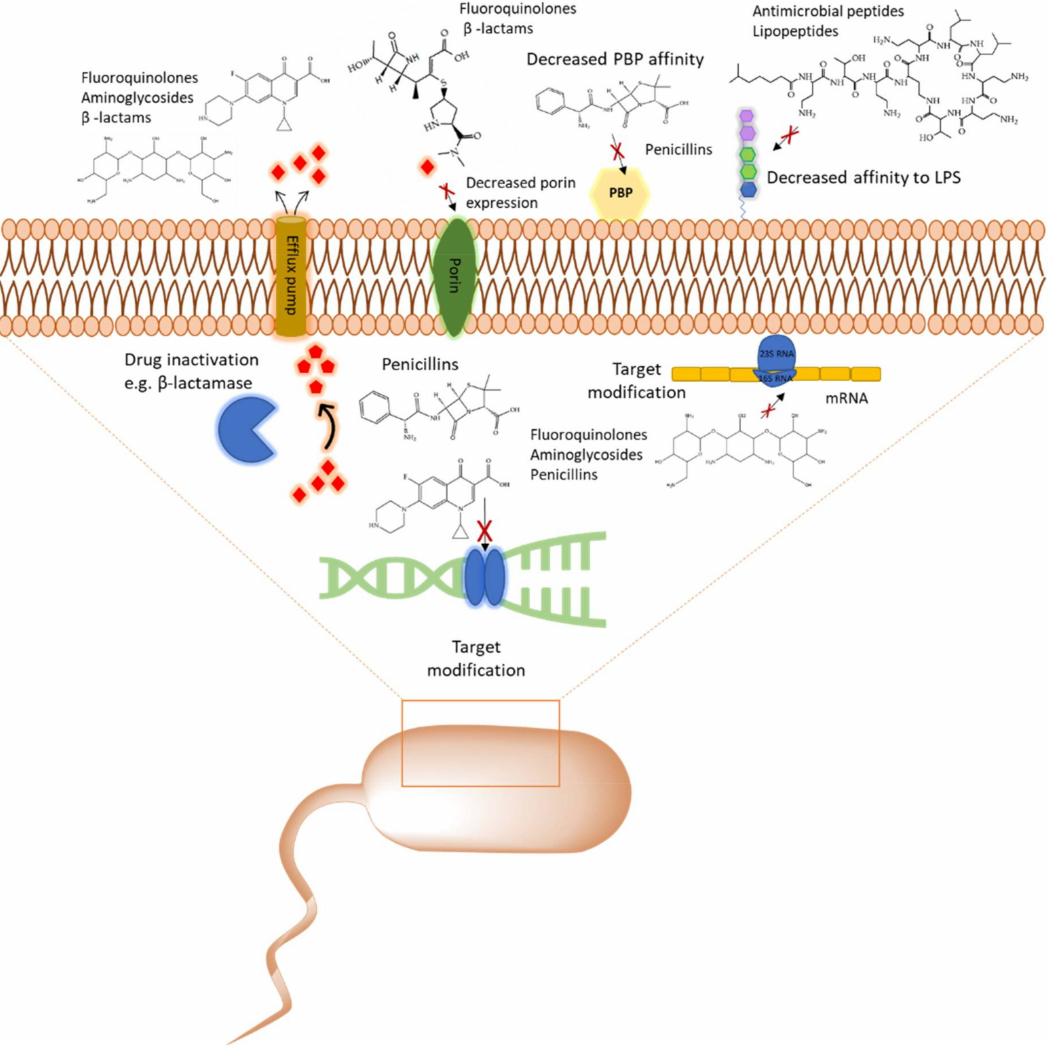
Figure 1. Overview of the common antibiotic resistance mechanism in bacteria. Molecular mechanisms of antibiotic resistance that includes target modification, drug inactivation, decreased a ffi nity to lipopolysaccharides (LPS) and penicillin binding protein (PBP), and expression of porins and e ffl ux pumps are